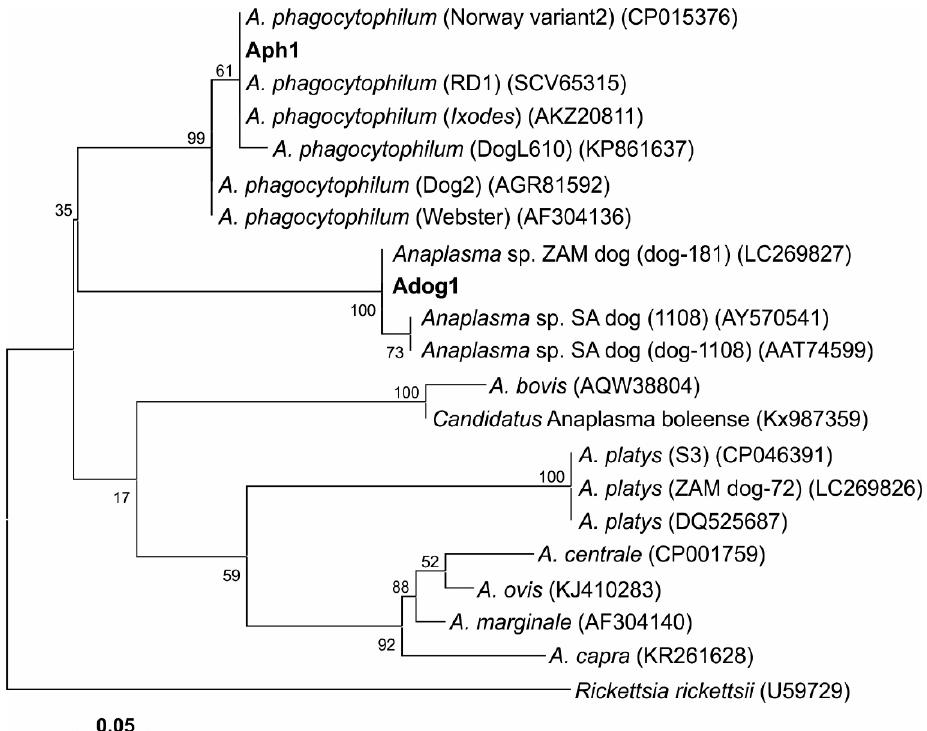
Figure 3. Maximum likelihood phylogenetic tree based on GltA deduced amino acid sequences showing the phylogenetic relationship between the obtained Anaplasma GltA sequence variants and related Anaplasma species. The GltA variants were designated as A. phagocytophilum Aph1 and Anaplasma sp. ZAM dog Adog1/GltA. Sequence accession numbers are shown in parentheses. The evolutionary history was inferred by using the maximum likelihood method based on the JTT matrix-based model. The tree with the highest log likelihood (-657.40) is shown. The percentage of trees in which the associated taxa clustered together is shown next to the branches. The tree is drawn to scale, with branch lengths measured in the number of substitutions per site. All positions with less than 95% site coverage were eliminated. There were a total of 52 positions in the final dataset. Evolutionary analyses were conducted in MEGA7 [49] .